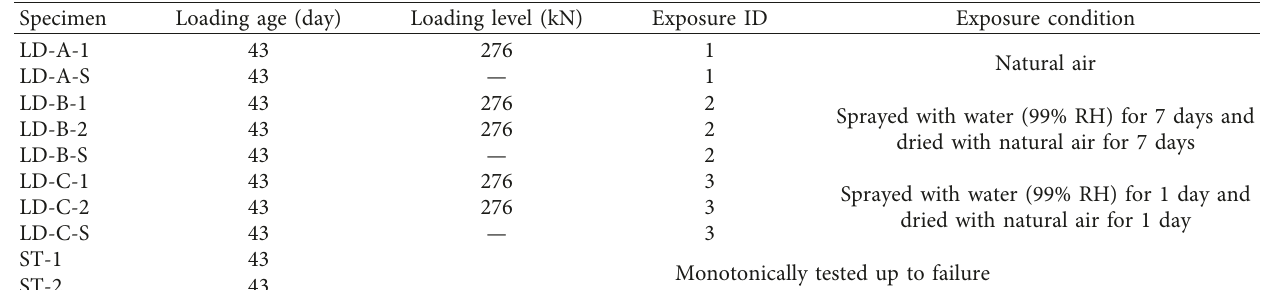
Figure 3: Dimensions and reinforced bar properties of the RC beams. Table 4: Details of prismatic specimens used for creep test in the present